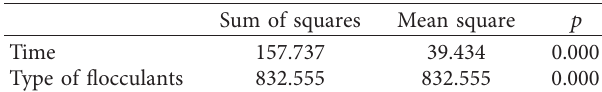
Table 2: Two-way ANOVA on different indicators in the floc- culation